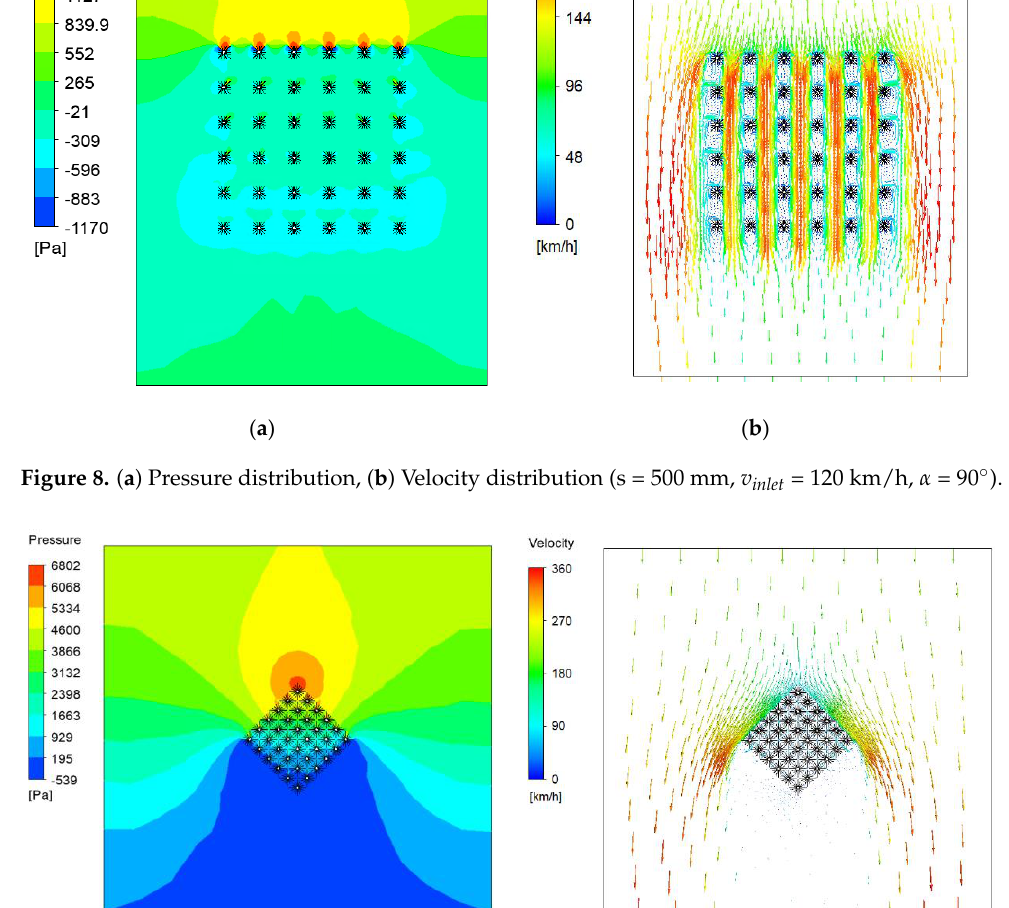
Figure 8. ( a ) Pressure distribution, ( b ) Velocity distribution (s = 500 mm, v inlet = 120 km/h,  = 90  ).